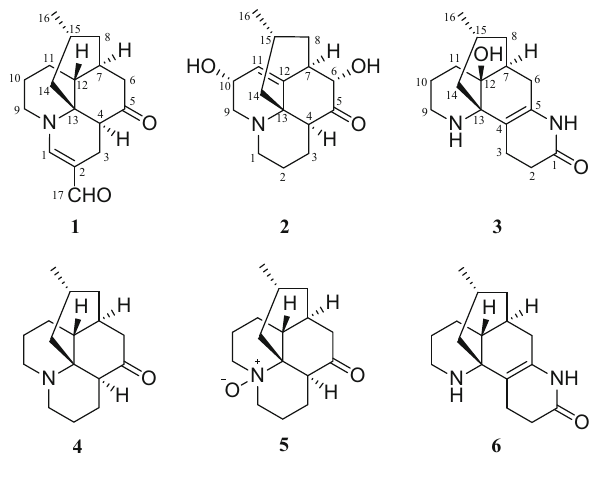
Fig. 1 Structures of compounds 1 –